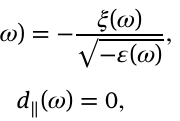
= 0 . 1, where the p = 𝑣 ∕ 𝜔 . conv F p